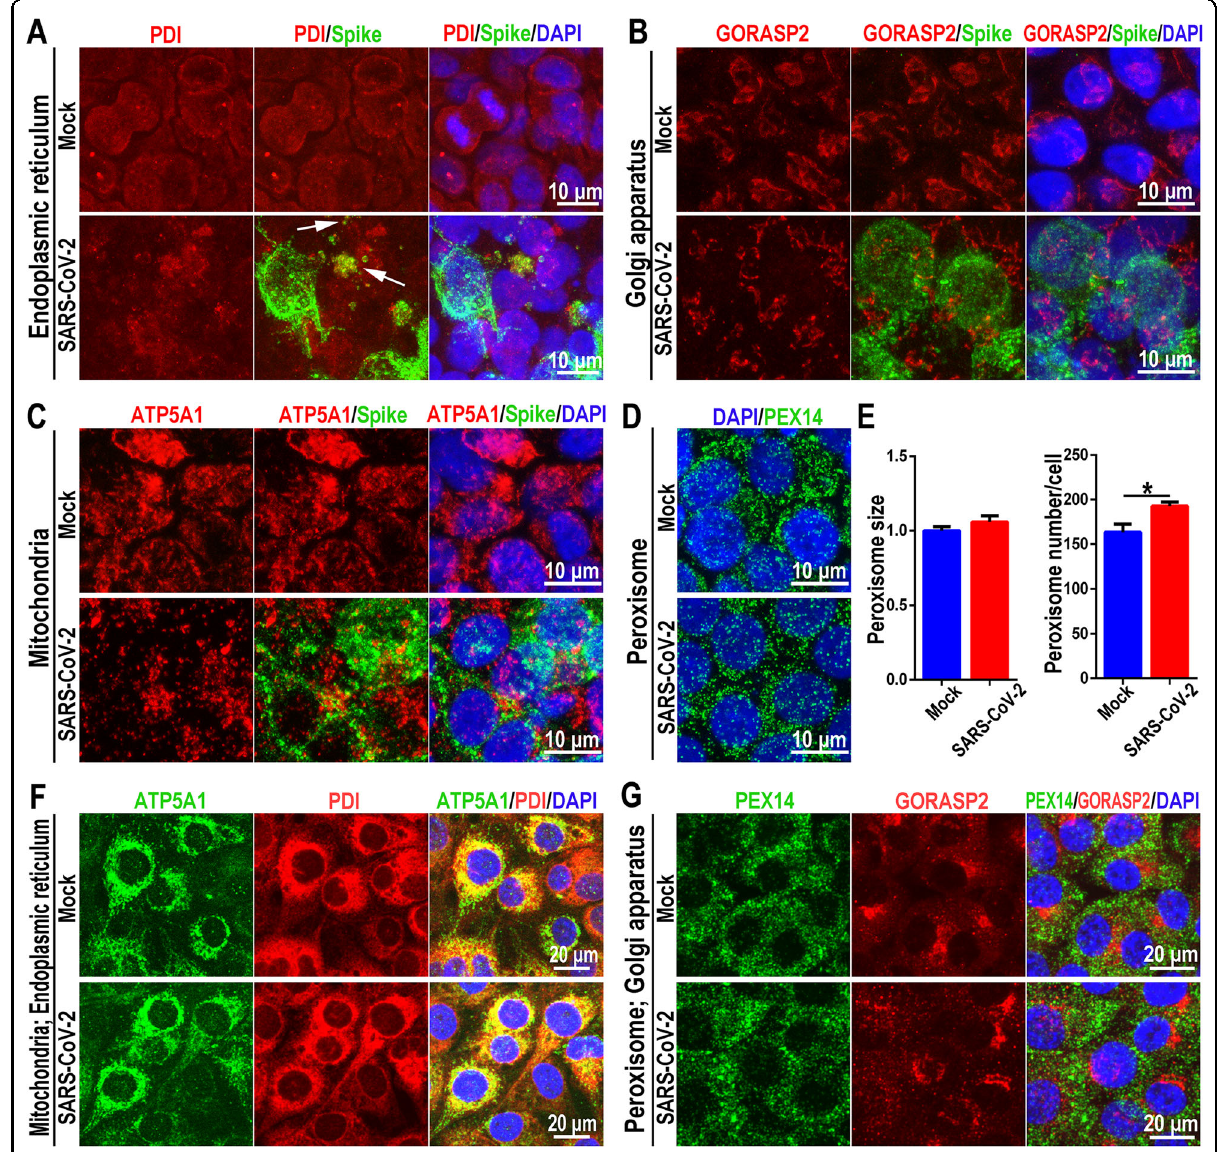
Fig. 2 Organelles of HPAEpiC cells and HULEC-5a cells following SARS-CoV-2 infection. a Representative images of endoplasmic reticulum immunostained with anti-PDI antibody for mock- or SARS-CoV-2-infected HPAEpiC cells. The white arrows indicated the co-localization of virus particles and endoplasmic reticulum within the host cells. b Representative images of Golgi apparatus immunostained with anti-GORASP2 antibody for mock- or SARS-CoV-2-infected HPAEpiC cells. c Representative images of mitochondria immunostained with anti-ATP5A1 antibody for mock- or SARS-CoV-2-infected HPAEpiC cells. d Representative images of peroxisomes immunostained with anti-PEX14 antibody for mock- or SARS-CoV-2- infected HPAEpiC cells. e Quanti fi cation of peroxisome size and density (number/cell) for mock- or infected cells in ( d ). Data were analyzed by Student ’ s t test (*: P < 0.05). Data represent four independent experiments, and more than 150 cells for each group were quanti fi ed. Data were presented as mean ± SEM. f Representative images of mitochondria and endoplasmic reticulum of mock- or SARS-CoV-2-infected HULEC-5a cells. g Representative images of peroxisomes and Golgi apparatus of mock- or SARS-CoV-2-infected HULEC-5a cells. All results are representative for three independent